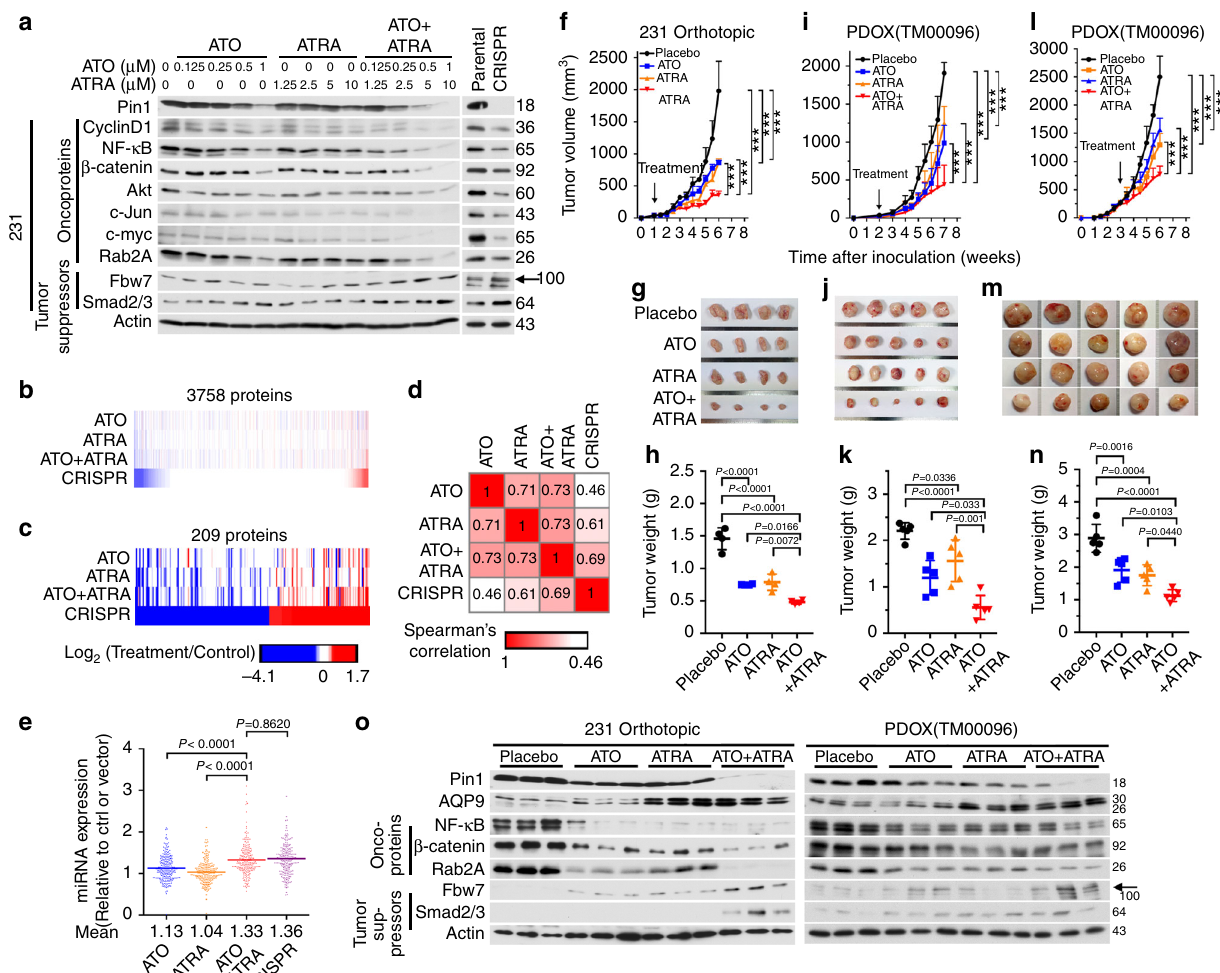
Fig. 5 ATO and ATRA cooperatively ablate Pin1 and inhibit multiple Pin1-regulated oncogenic pathways and tumor growth in TNBC in vitro and in vivo including PDOXs. a ATO and ATRA cooperatively turn off many oncoproteins and on many tumor suppressors, like Pin1 KO. The 231 and 159 cells were treated with different concentrations of ATO and/or ATRA for 72 h, followed by IB, with Pin1 KO cells as controls. b – d ATO and ATRA cooperatively induced global protein expression like Pin1 KO. The 231 cells were treated with ATO and/or ATRA or DMSO for 72 h, followed by quantitative mass spectrometry analyses, with Pin1 KO 231 cells as a control. Three thousand seven hundred and fi fty-eight proteins passed the abundance fi lter ( b ), and 209 proteins were altered by >1.5-fold ( c ). The log 2 transformed ratio of treated versus control was used to generate the heatmap in GENE-E. The Spearman's correlation matrix for the 209 altered proteins are shown and their P values are all below 2.2e − 16, except P value for ATO and Pin1 KO being 3.5e − 12 ( d ). e ATO and ATRA globally upregulates microRNA expression like Pin1 KO. MicroRNAs of ATO-treated and/or ATRA-treated 231 cells and Pin1 KO 231 cells were pro fi led by NanoString. Data are presented as relative to microRNA expression of DMSO-treated (Ctrl) 231 cells or vector CRISPR 231 cells through the dot density plot. The P values were determined by Student ’ s t test. f – h ATO and ATRA cooperatively inhibit tumor growth in TNBC 231 orthotopic xenografts. The 231 cells were transplanted into mammary fat pads, and 1 week later, treated with ATO and/or ATRA. Tumor sizes were measured ( f ) and mice were sacri fi ced after 6 weeks to collect tumor tissues ( g ) and measure their weights ( h ). i – n ATO and ATRA cooperatively inhibit tumor growth in TNBC PDOXs. TNBC patient-derived tumors were transplanted, followed by treating mice with ATO and/or ATRA 2 – 3 weeks after xenograft when tumors were notable ( i – k ) or reached about 360 mm 3 ( l – n ). o ATRA induces AQP9 to cooperate with ATO to downregulate Pin1 and Pin1 oncogenic substrates and upregulate Pin1 tumor-suppressive substrates in human cells and PDOXs, assayed by immunoblot. The results are expressed as mean ± SD and the P values were determined by ANOVA or Student ’ s t test. n = 4 – 5